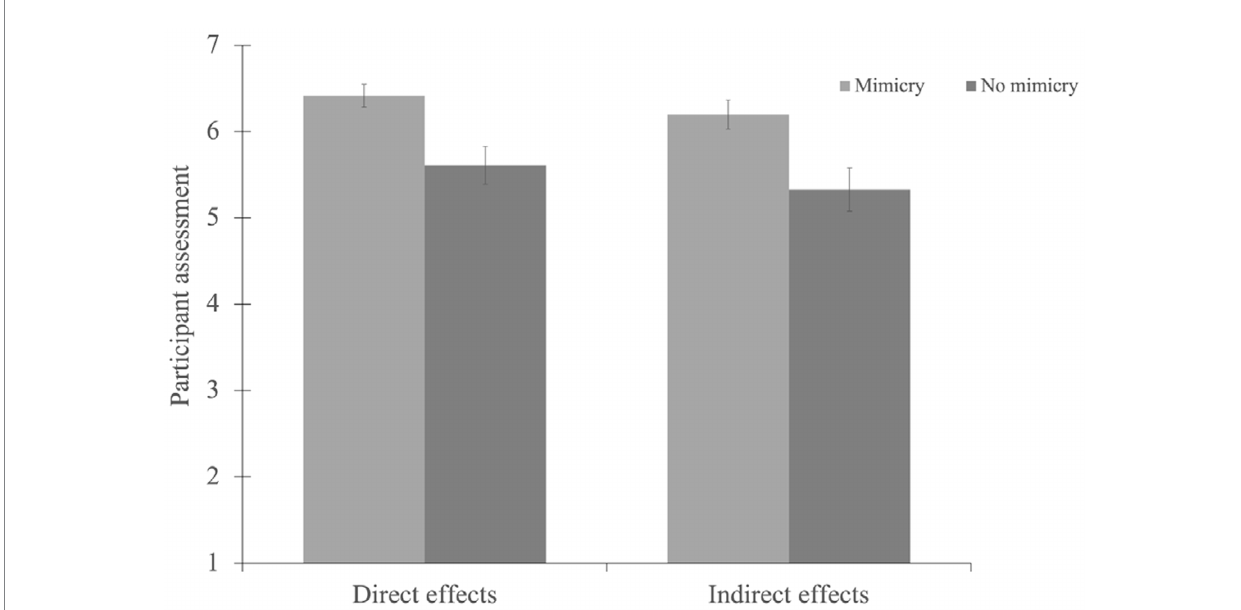
FIGURE 1 Participants’ evaluation in the Pretest as a function of experimental condition and directness. Bars represent mean values. Error bars represent standard errors of